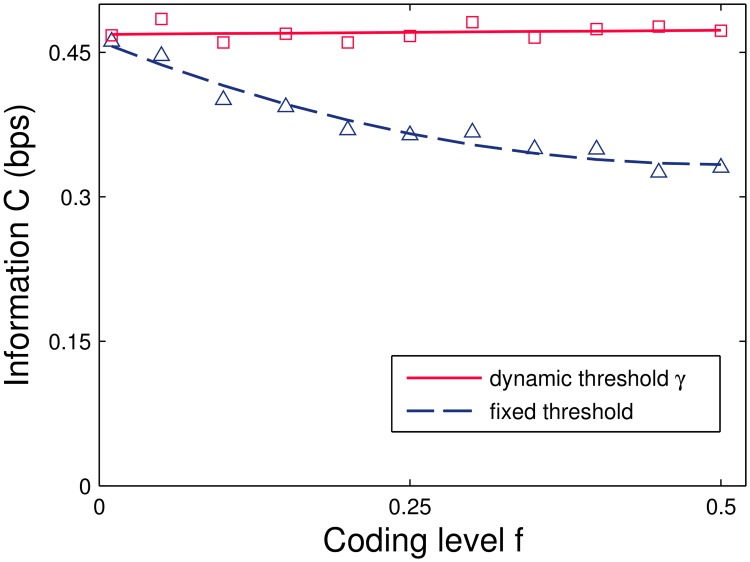
Information C in bits per synapse for binary (0 or 1) input patterns as a function of the input coding level f.Average values for the dynamic-threshold model, where h is given by Eq 11, and average values obtained with a fixed threshold θfN — note the threshold scaling with fN instead of fN due to the 0/1 input activity. Potentiation and depression were balanced (Eqs 9 and 10) to match the coding level. While the adjusted model is insensitive to f, the information achieved by the uncorrected model approaches that of the original one for sparse input patterns. Simulations performed at moderate memory load α = 0.5 and system size N = 1000.